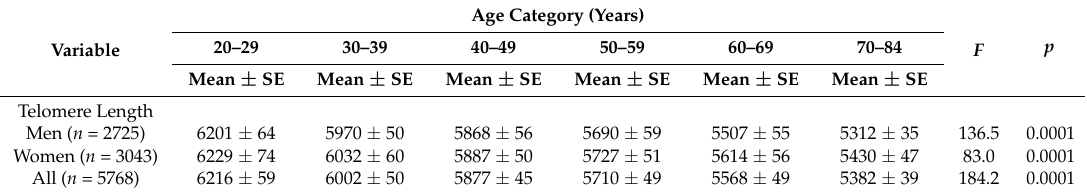
Table 2. Mean differences in telomere length (base pairs) across age categories in US men and women.